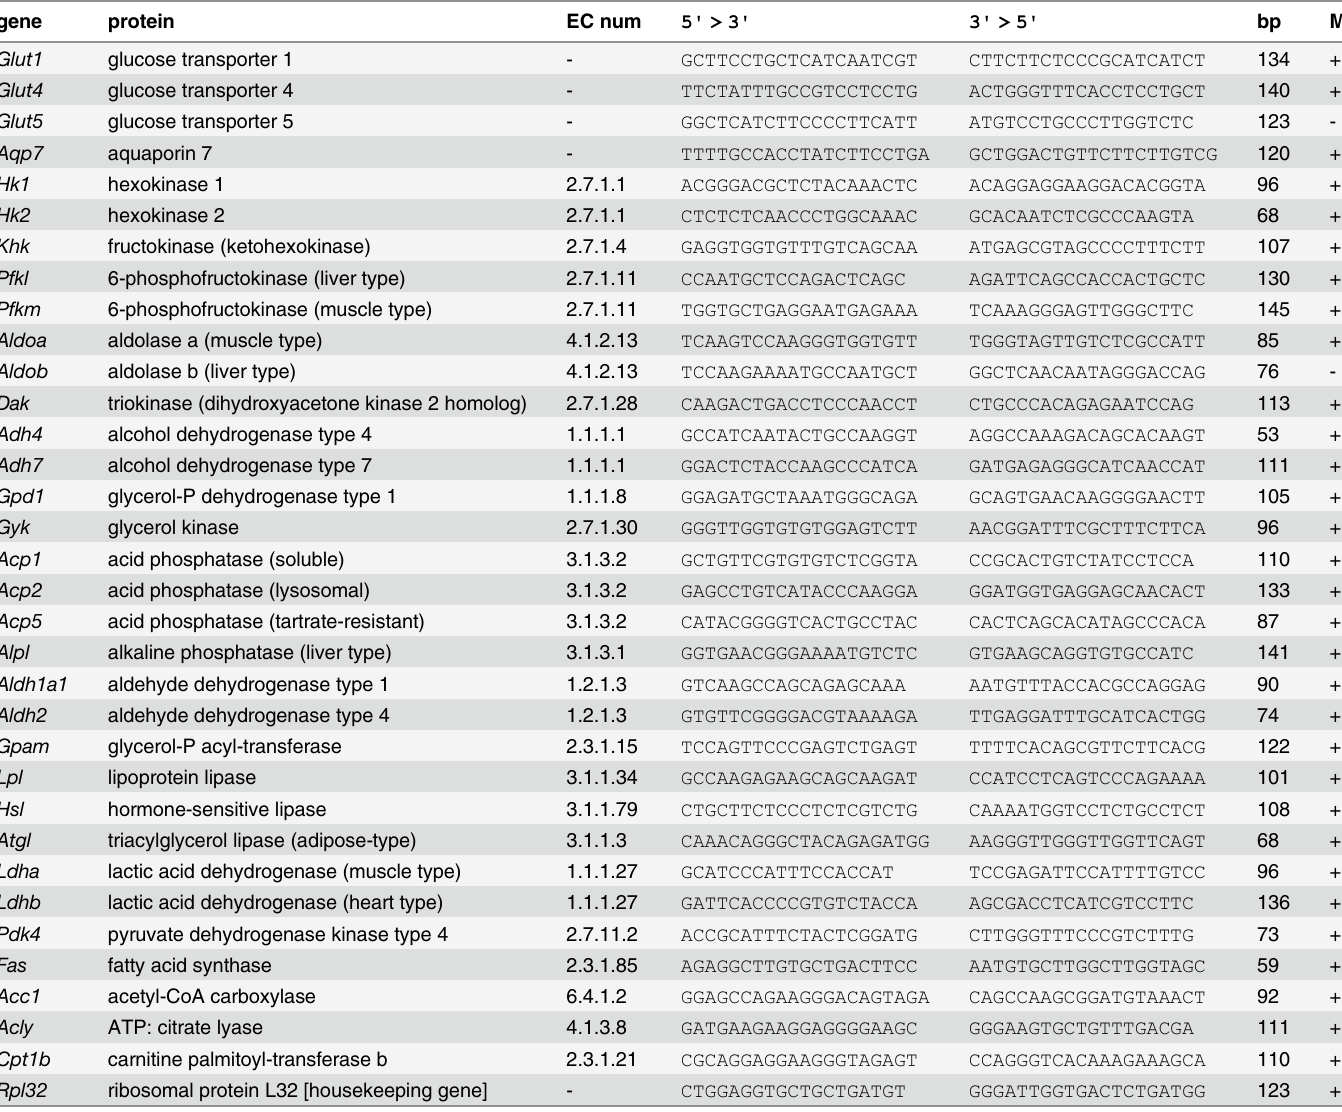
Table 1. Genes (and their corresponding proteins, and primer sequences used) which expression was analyzed in mature 3T3-L1 cells incubated in the presence of varying concentrations of glucose and